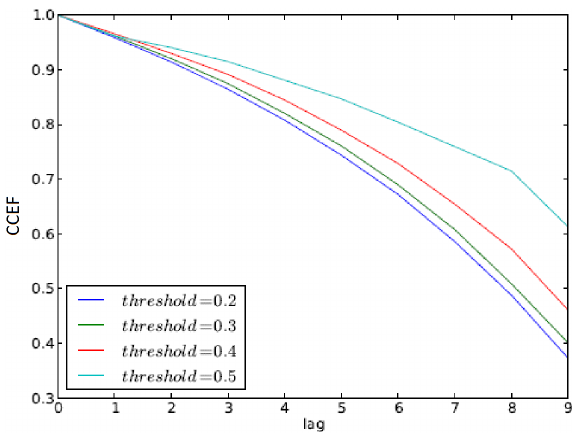
Fig. 3: CCEF for networks from the START model with peri- odic (green) and linearly increasing (blue) forcing parameter F. The error bars indicate the standard deviation of the CC size estimates.